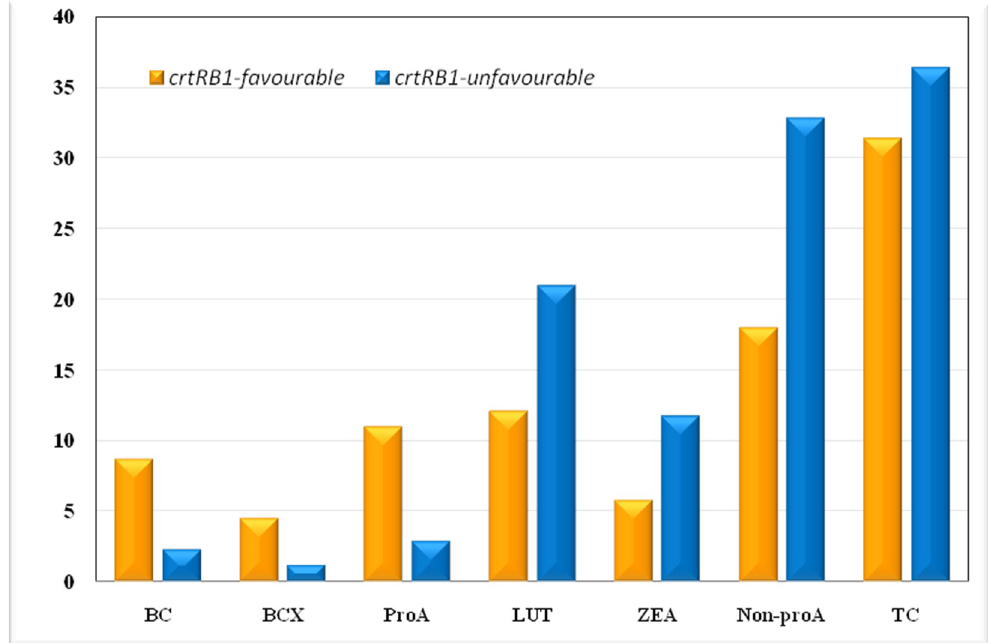
Fig 4. Mean of carotenoids among inbreds with favourable and unfavourable alleles of crtRB1 . https://doi.org/10.1371/journal.pone.0245497.g004 Correlation among carotenoids and grain yield. Correlation analysis revealed that BC was positively correlated with BCX (r = 0.68 �� ). Whereas, BC and BCX were negatively corre- lated with LUT (r = -0.51, -0.57 �� ) and ZEA (r = -0.42 �� , -0.53 �� ), respectively. LUT and ZEA, however, were positively correlated (r = 0.70 �� ). ProA and non-proA carotenoids were also negatively correlated (r = -0.57 �� ). BC, BCX and proA were not correlated with TC, while LUT (r = 0.72 �� ), ZEA (r = 0.72 �� ) and non-proA (r = 0.78 �� ) showed strong positive association with TC. The present study revealed that kernel carotenoid components and grain yield exhib- ited non-significant relationships (r = -0.18 to 0.15) except for ZEA (r = 0.29 �� ). Combining ability analysis for carotenoids ANOVA for line × tester. Pooled ANOVA revealed that environment was highly signifi- cant for all the carotenoids except for ZEA (Table 6). Line effect was significant only for ZEA, Table 5. Pooled ANOVA for different carotenoids in hybrids across three locations. Sources of